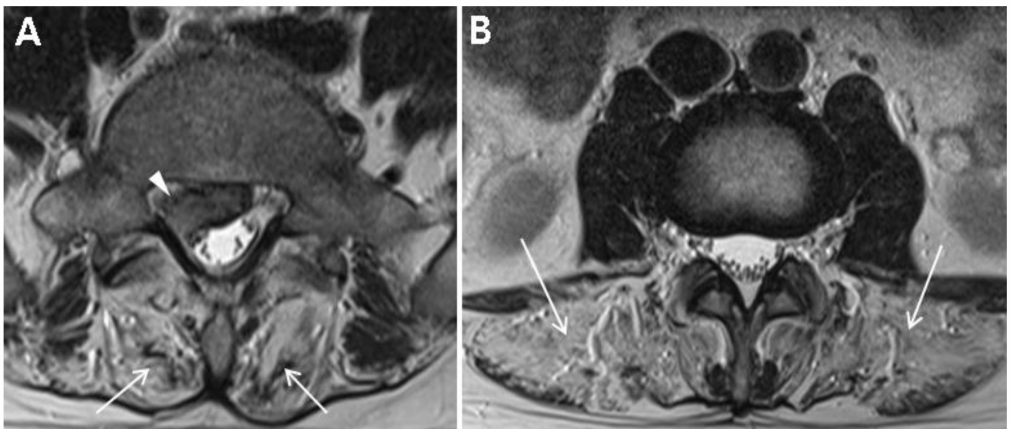
Figure 1. Magnetic resonance image (MRI) of the lumbar spine. ( A ) L5–S1 disc extrusion on the right (arrowhead) and severe fatty degeneration of the erector spinae and multifidus (arrows) on an axial T2WI of lumbar spine MRI. ( B ) Severe fatty degeneration of the lumbar paraspinalis (arrows) at the L3 vertebral body level.